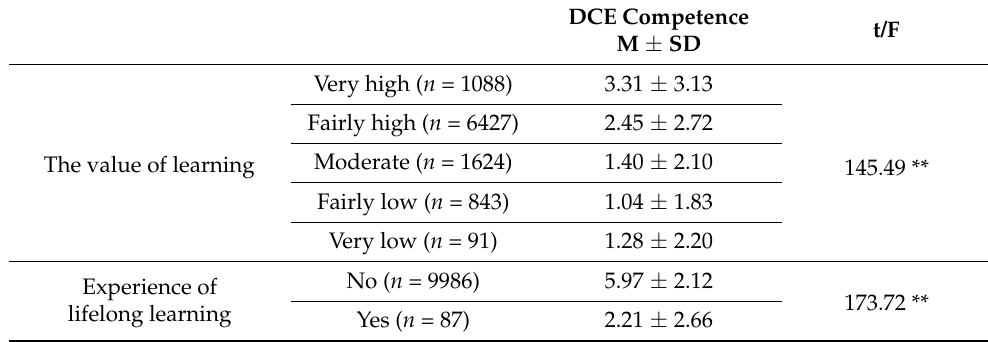
Table 4. DCE competence based on education related factors ( n =